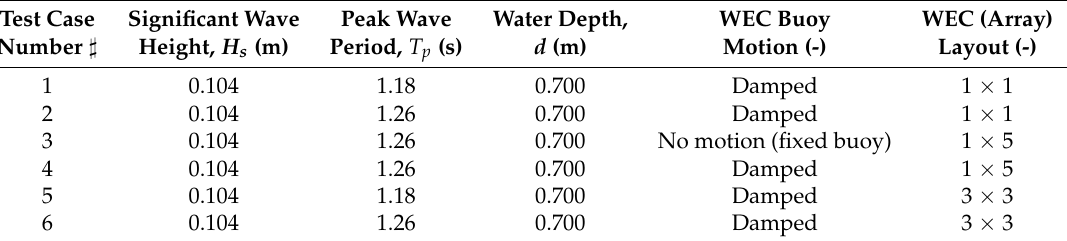
Table 1. “Test Case” program for irregular waves, and different Wave Energy Converter (WEC) (array) configurations. Test Case Significant Wave Peak Wave Water Depth, WEC